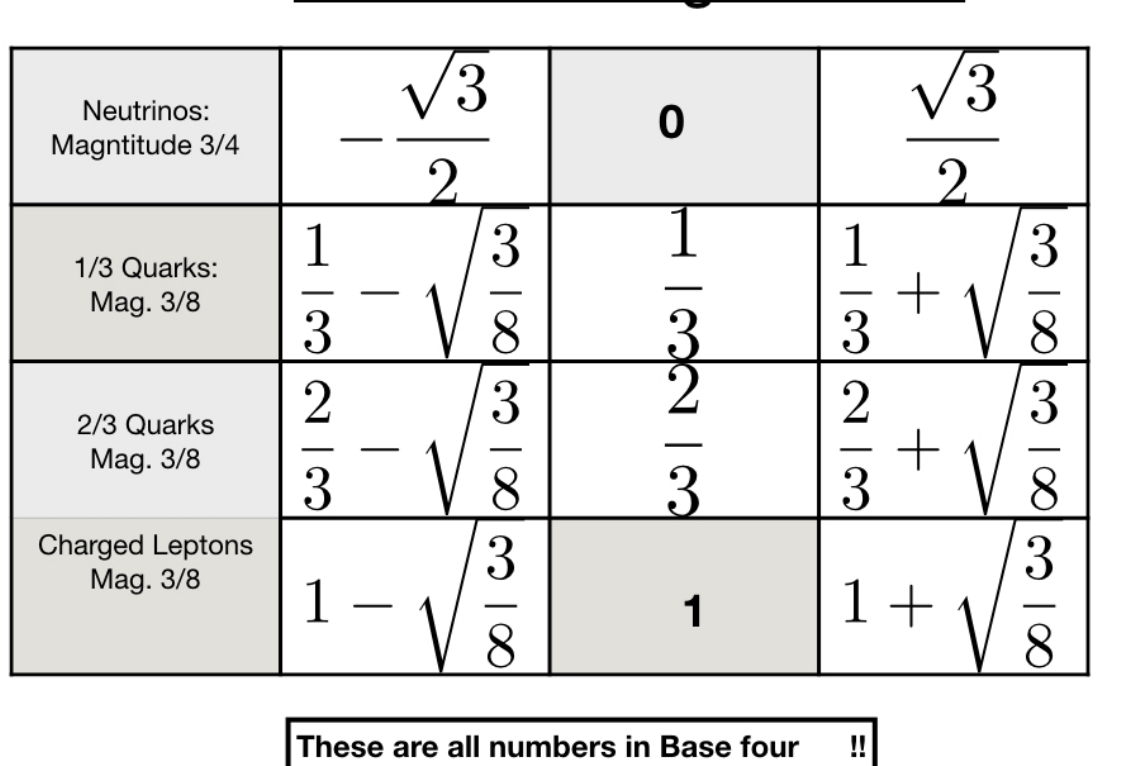
Figure 4. The eigenvalues of the characteristic equation of the exceptional Jordan algebra, for quarks and leptons